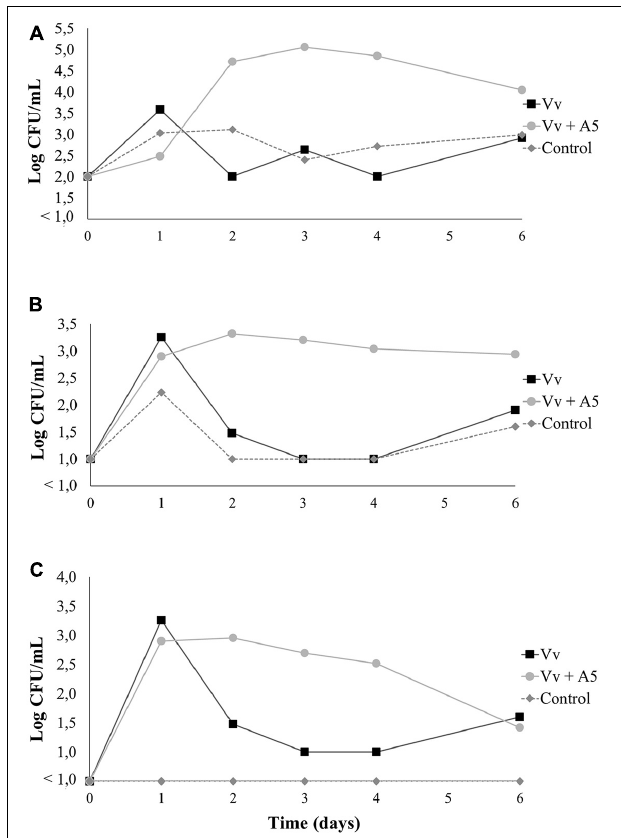
FIGURE 7 | Total aerobic bacteria (A) , total vibrio (B) , and Vibrio vulnificus (C) levels in seawater from bioassay 2 (inoculation with V. vulnificus prior to inoculation with A5). Three treatments are shown: Vv inoculated with V. vulnificus only ( (cid:4) ), Vv + A5 first inoculated with V. vulnificus and then